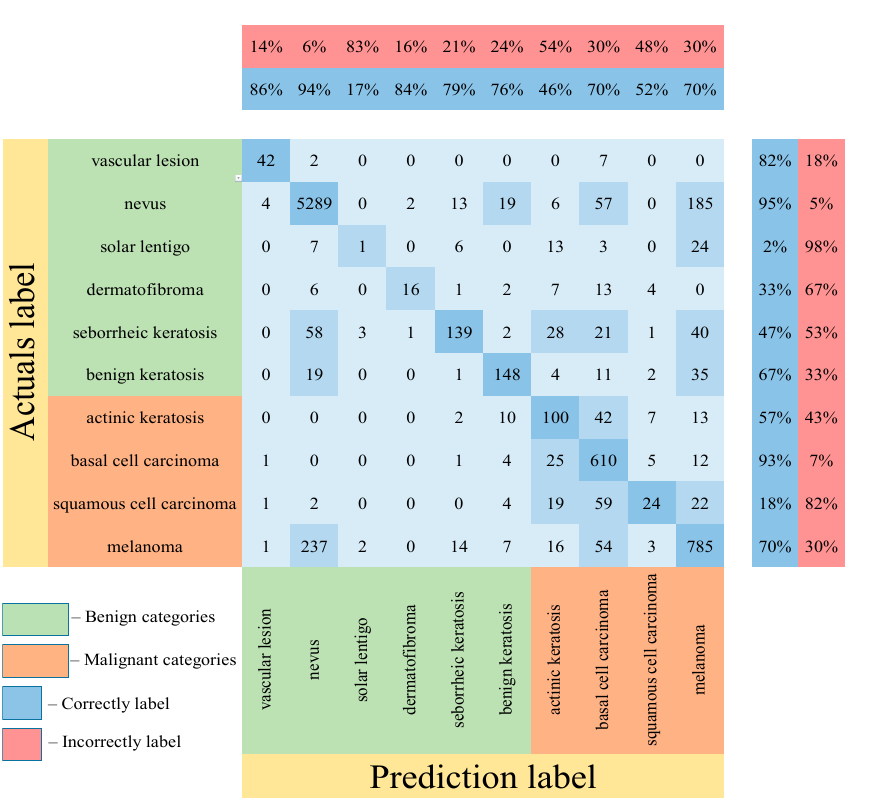
Figure 14. Confusion matrix in the testing results in a multimodal neural network system for recog ‐ nizing pigmented skin lesions based on CNN SqueezeNet.